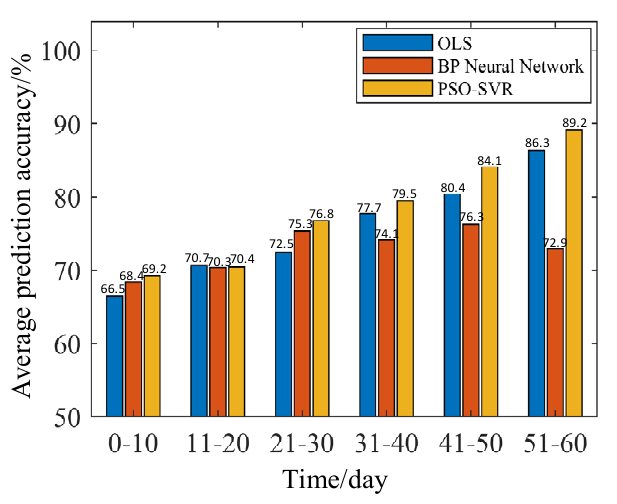
Figure 14. Comparison of the average prediction accuracy of the three methods.